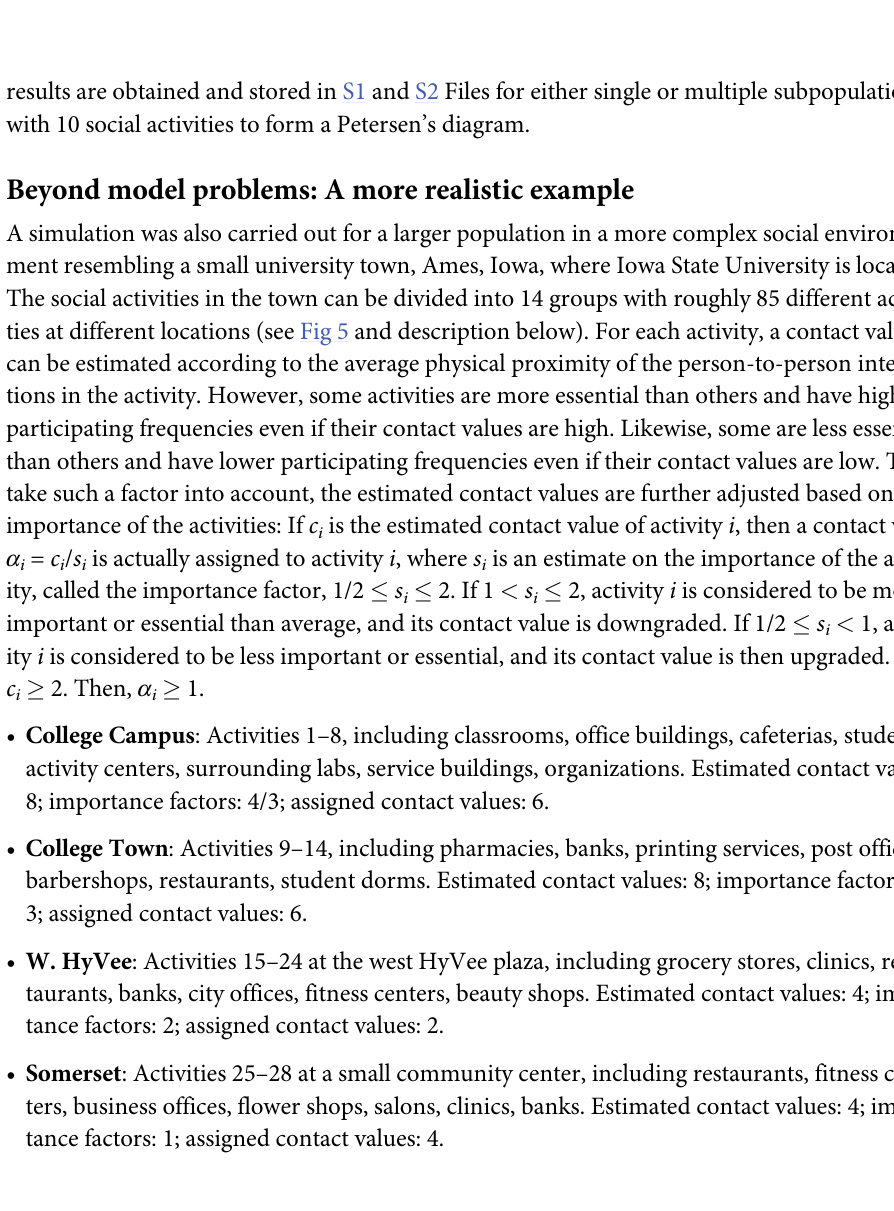
Table Legends: Act—activities. Test #—simulation test. Each column—ending frequencies for corresponding activities for P 2 .